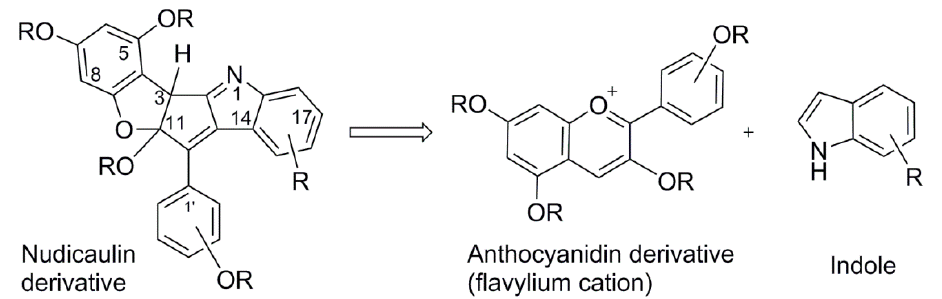
Molecules 2018 , 23 , x FOR PEER REVIEW 4 of 14 Figure 3. In vitro formation of nudicaulins in an extract of orange P. nudicaule petals supplemented with indole solution. ( A ) HPLC elution profile (460 nm, HPLC 1, method 2) of an extract without the addition of HCl (blue dotted line: 10 min; gray line: 70 min after indole addition) and after adding HCl (dark green line: 10 min; light green line: 70 min after indole addition), indicating the conversion of pelargonidin glucosides into nudicaulins. ( B ) Petal extracts without HCl: the color stays pale orange, indicating a mixture of pelargonidin glucosides and nudicaulins. Petal extracts with HCl: the color changes from bright orange (color of the pelargonidin flavylium cations and nudicaulins in mixture) to bright yellow, the color of nudicaulins. 2.2. Synthesis of O-Methylated Nudicaulin Derivatives According to the “rule of five” for drug-likeness [13], the molecular mass of glucosidic nudicaulins, e.g., nudicaulins I and II (Figure 1, molar mass 871) far exceeds the optimum defined for most pharmacologically active compounds. An in silico drug-likeness prediction using MolCart [14] resulted in positive scores for both nudicaulin glycosides and aglycons. Hence, bioactivity does not necessarily require glycosylation. For these reasons, and for structural simplification, we aimed